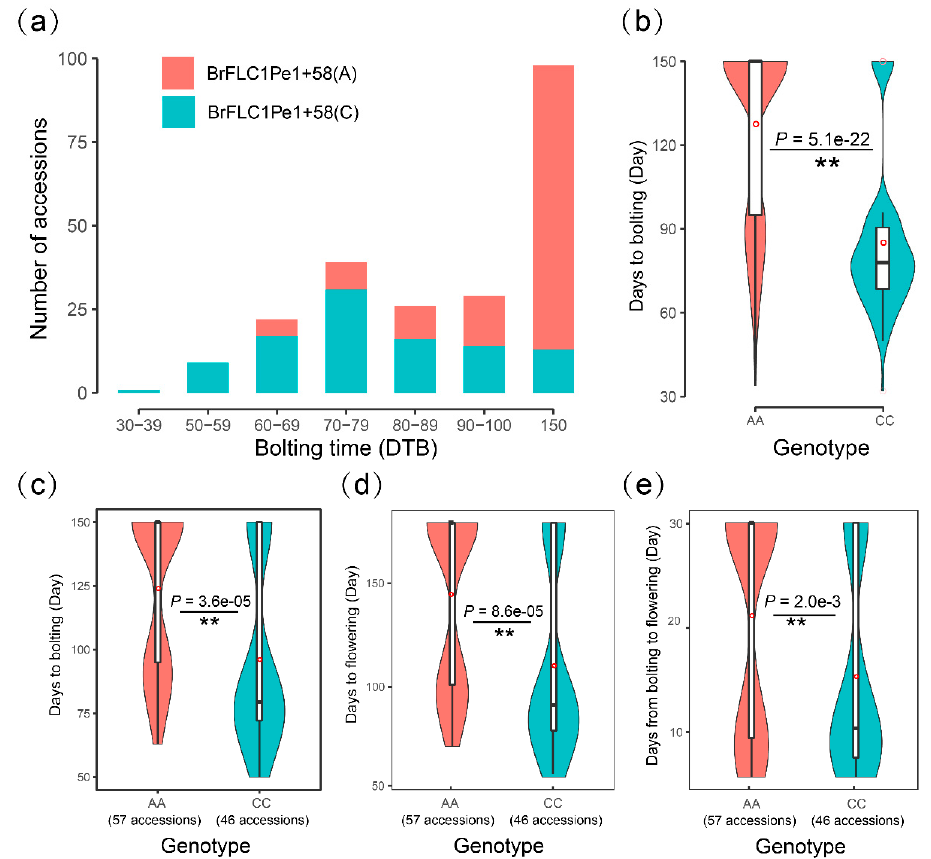
Figure 2. Frequency distribution of BrFLC1 Pe1+58 alleles and bolting time distribution in a B. rapa germplasm collection ( n = 236). ( a ) Distribution of BrFLC1Pe1+58 alleles with their associated bolting time. The heterozygous genotype was not included in the analysis because the number of accessions was too few; ( b ) distribution of bolting time for the accessions with different BrFLC1 Pe1+58 alleles; bolting time ( c ), flowering time ( d ), and the time from bolting to flowering ( e ) according to their BrFLC1 Pe1+58 alleles in the group of Chinese cabbage. Comparisons are done by Student-Newman- Keuls test with α = 0.01, and the marker (**) indicates the p -value <=